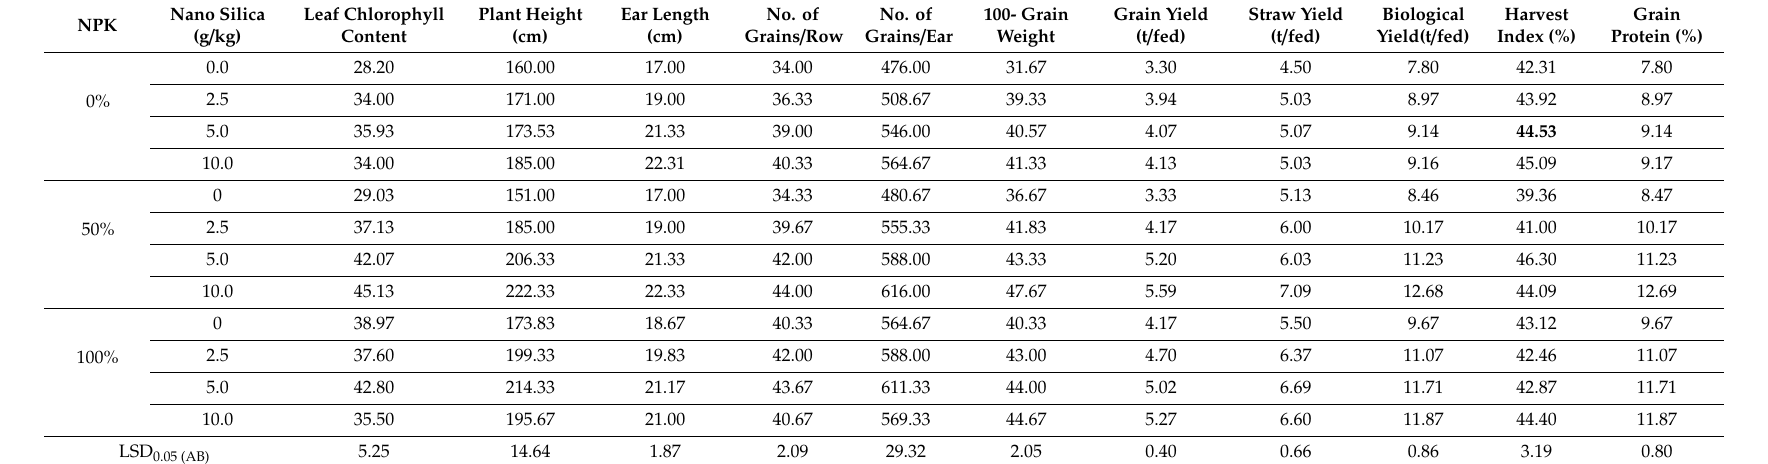
Table 3. The interaction e ff ect between mineral NPK fertilizers and nano silica (SiO 2 -NPs) concentrations on plant attributes of maize in an average of the two seasons 2018 and